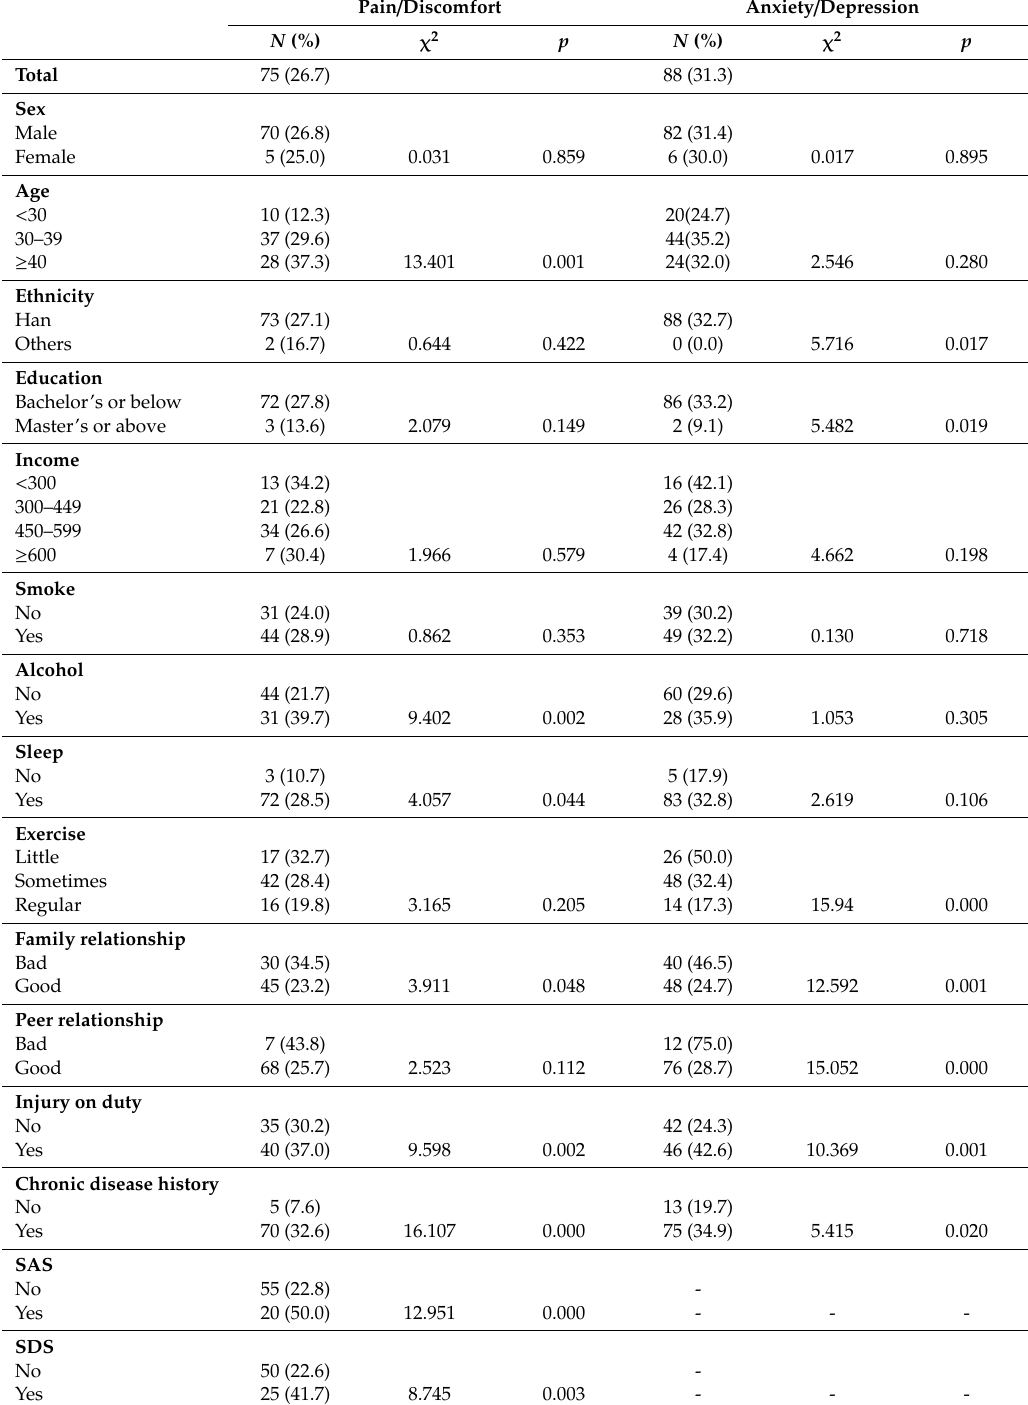
Table 2. Percentage of reported problems on the pain / discomfort and anxiety / depression dimensions of the